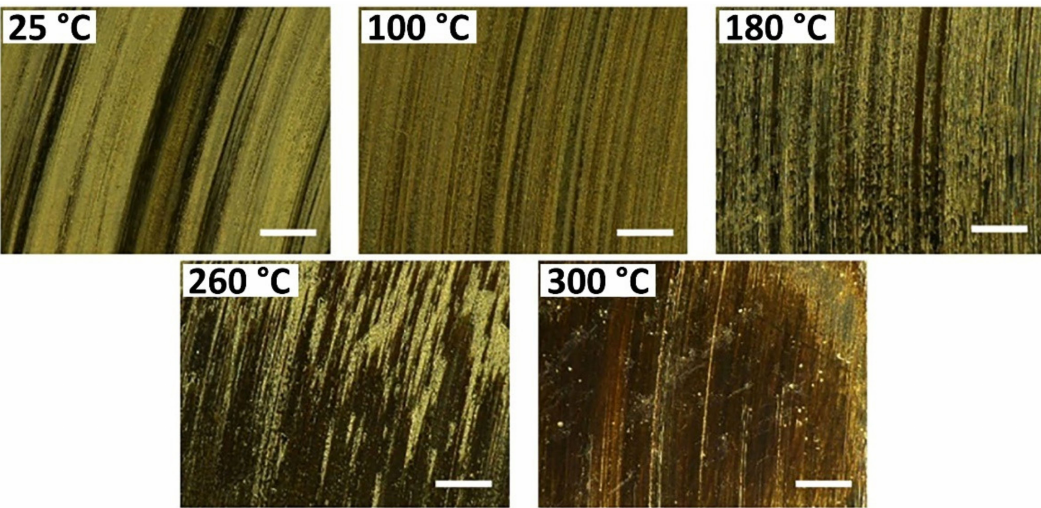
Figure 4. Optical microscopic images of steel pins after sliding at different temperatures against graphene/ATSP nanocom- posite coatings (Reproduced with permission from K. Bashandeh, P. Lan, J. L. Meyer, Tribology Letters; published by Springer Nature, 2019)